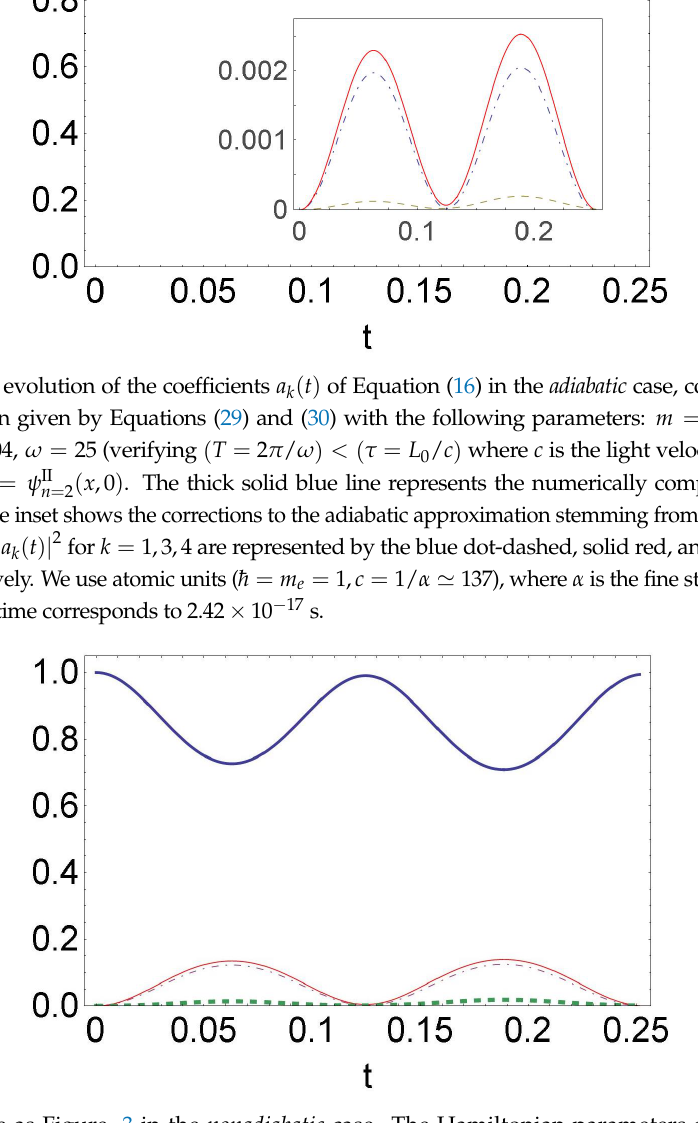
Figure 4. Same as Figure 3 in the nonadiabatic case. The Hamiltonian parameters are those given for Figure 3 except we set here q 2 = 7.33 (atomic units are used). The initial state is again φ ( x ,0 ) = ( x ,0 ) . The coefficients | a ( t ) | 2 are shown by the curves in thick solid blue ( k = 2), dot-dashed ψ II k n = 2 ( k = 1), solid red ( k = 3), and green dashed ( k = 4). The coefficients a k ( t ) for k ≥ 5 are of smaller and decreasing